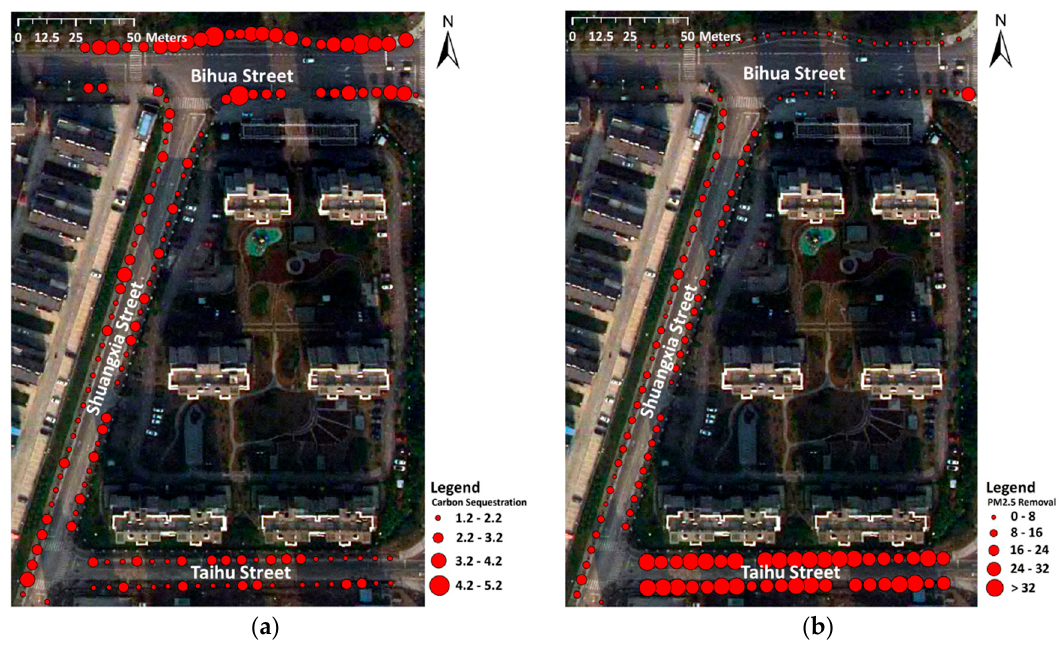
Table 7. PM 2.5 concentrations and wind speeds of Nantong in April 2015.